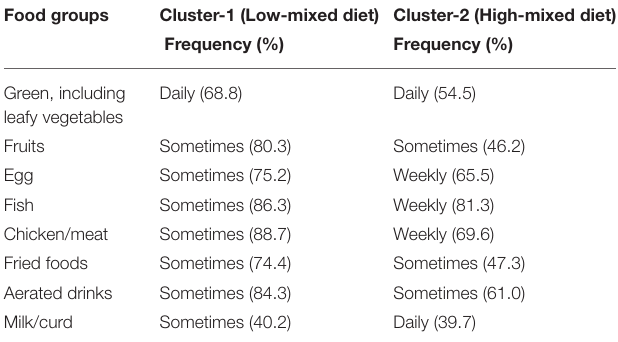
TABLE 3 | Percent distribution of two clusters according to selected food groups. Food